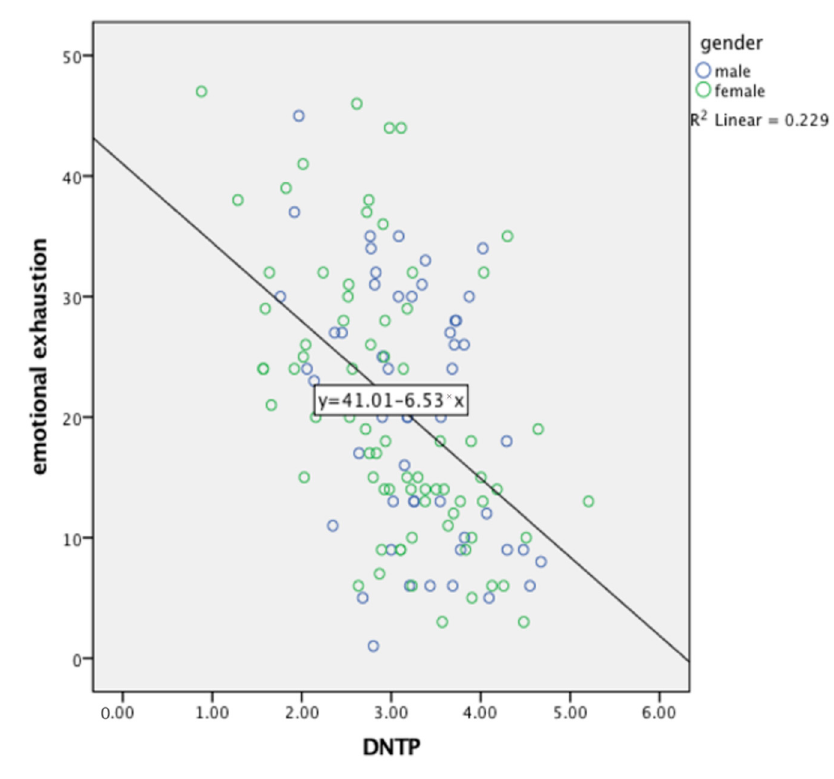
Figure 1. Linear regression analysis of DNTP and emotional exhaustion.